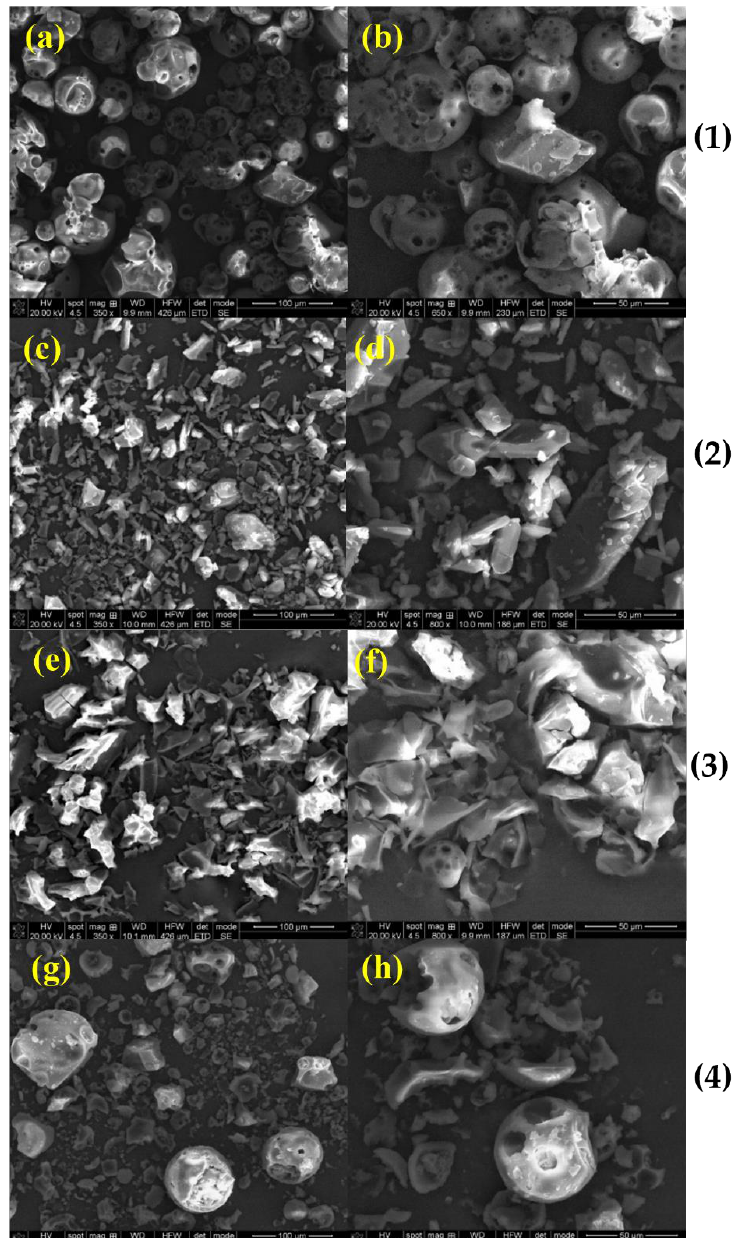
Figure 6. SEM images, at different magnifications, of ( 1 ) Nim – HP- β -CD physical mixture; ( 2 ) Nim – HP- β -CD coprecipitation method; ( 3 ) Nim – HP- β -CD lyophilization method; and ( 4 ) Nim – HP- β -CD kneading method; ( a ) 350 ×; ( b ) 650 ×; ( c ) 350 ×; ( d ) 800 ×; ( e ) 350 ×; ( f ) 800 ×; ( g ) 350 ×; ( h ) 800 ×. X-ray diffraction: The XRD diffractograms of pure compounds (Nim, HP- β -CD, and Thus, the Nim – HP- β -CD physical mixture shows some broken cyclodextrin shells Me- β -CD) are displayed in Figure 8a–c. The XRD pattern of Nim (Figure 8a) exhibited a series of well-defined and strong diffraction peaks with maxima at 2 θ = 6.52 ◦ , 12.83 ◦ , coprecipitation derived sample gives evidence of the cyclodextrin shell shards and smaller 17.32 ◦ , 20.26 ◦ , 23.73 ◦ , 24.80 ◦ , and 26.36 ◦ , which indicated its crystalline nature, according to the JCPDS card 00-410-7268. The XRD pattern of the Nim used in this study corresponds to that of the Nim crystal modification I (mod I) which is the racemic compound. Similar XRD patterns were also evidenced in the literature [12,32,33]. Both pure HP- β -CD (Figure 8b) and Me- β -CD (Figure 8c) were found to be in the amorphous phase, as evidenced by the appearance of a broad peak at around 2 θ = 9.7 ◦ and 18.6 ◦ for HP- β -CD, and at around 2 θ = 11.2 ◦ and 18.3 ◦ for Me- β